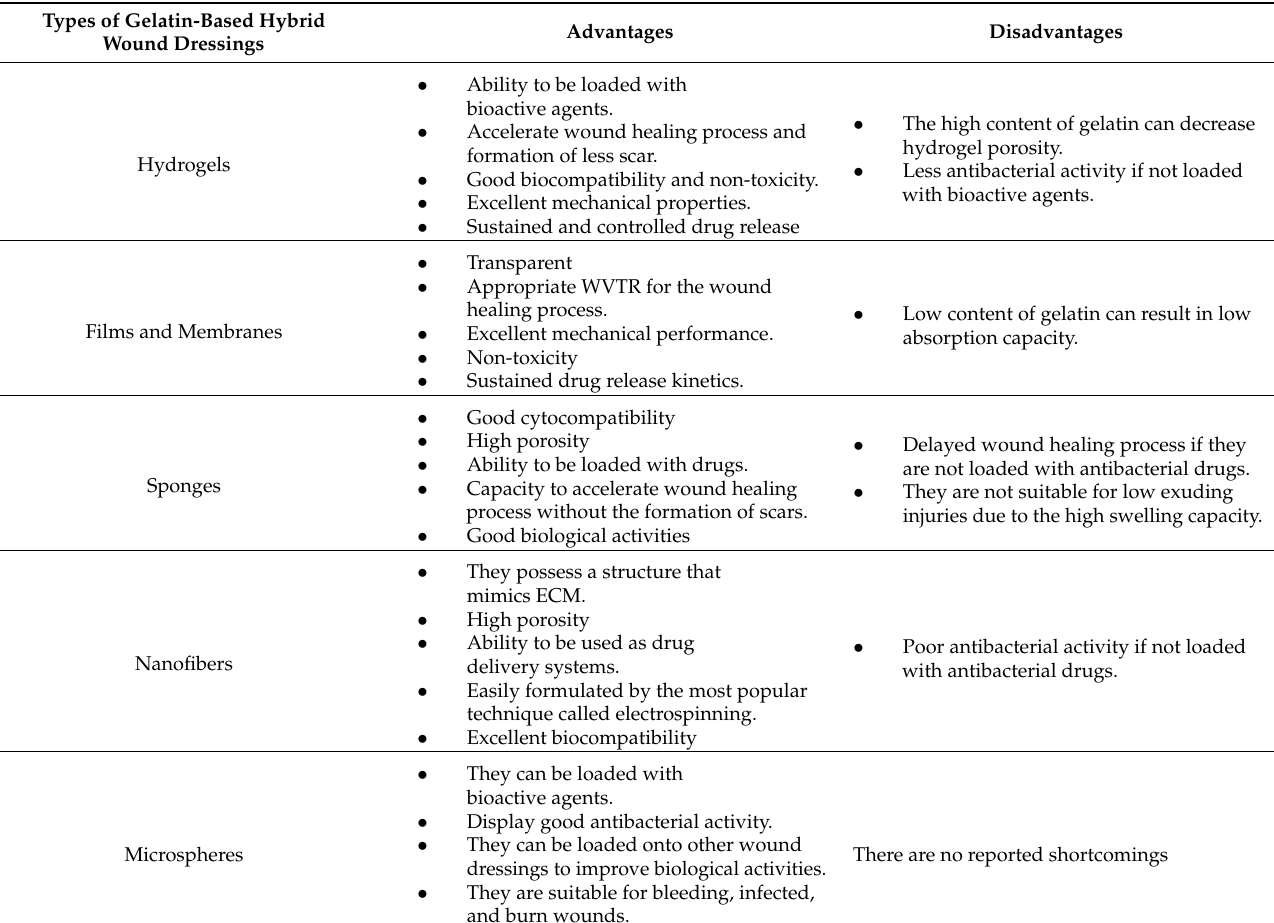
Table 5. Summarizing the Advantages and Disadvantages of Gelatin-based Hybrid Wound Dressings. Types of Gelatin-Based Hybrid Wound